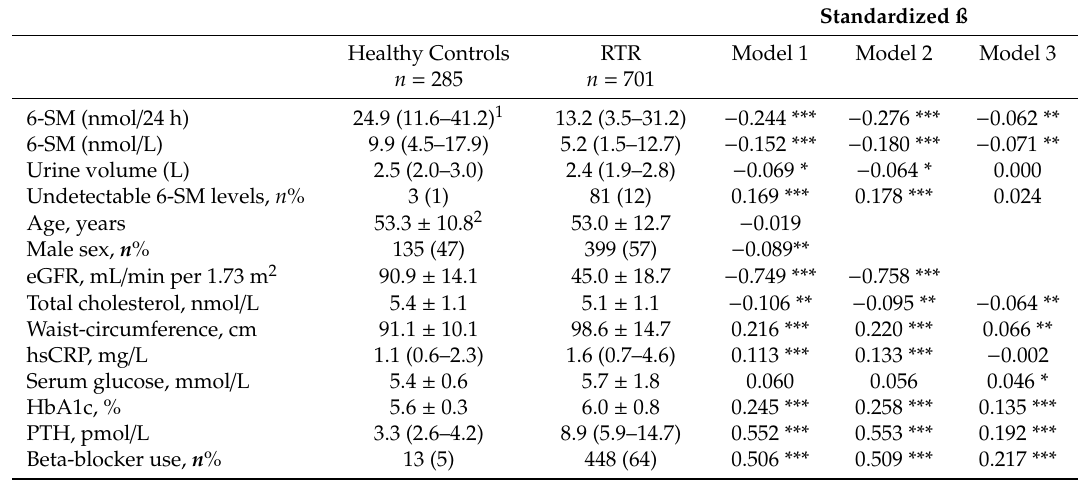
Table 1. Baseline characteristics comparison between healthy controls and RTR